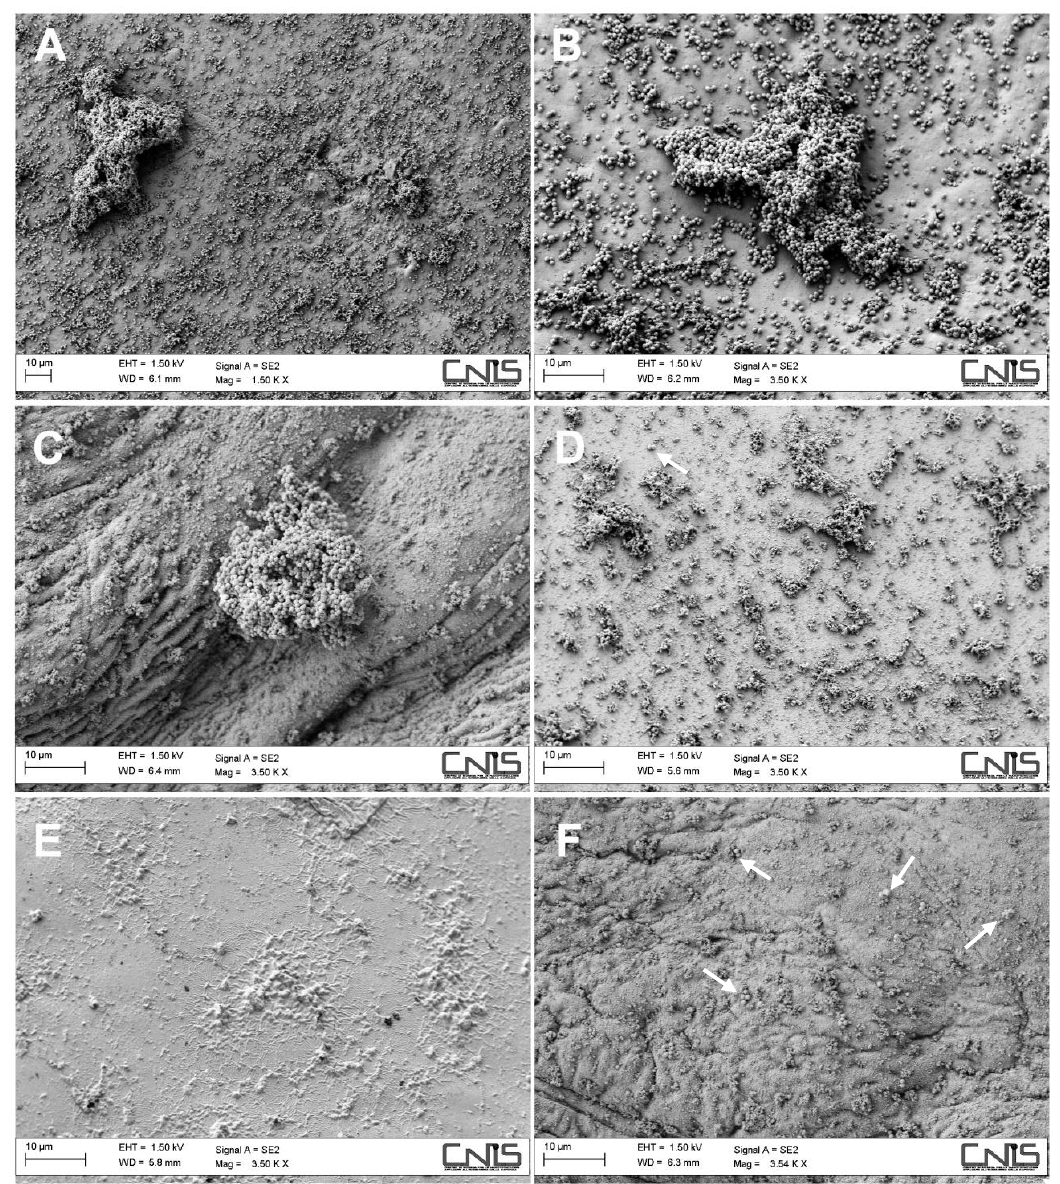
Figure 7. SEM micrographs of bacterial cells adhered onto CS at two magnifications ( A , B ), CS/HA1 ( C ), CS/HA5 ( D ), CS/HA10 ( E ) and CS/HA15 ( F ) matrices. White arrows indicate bacterial cells.